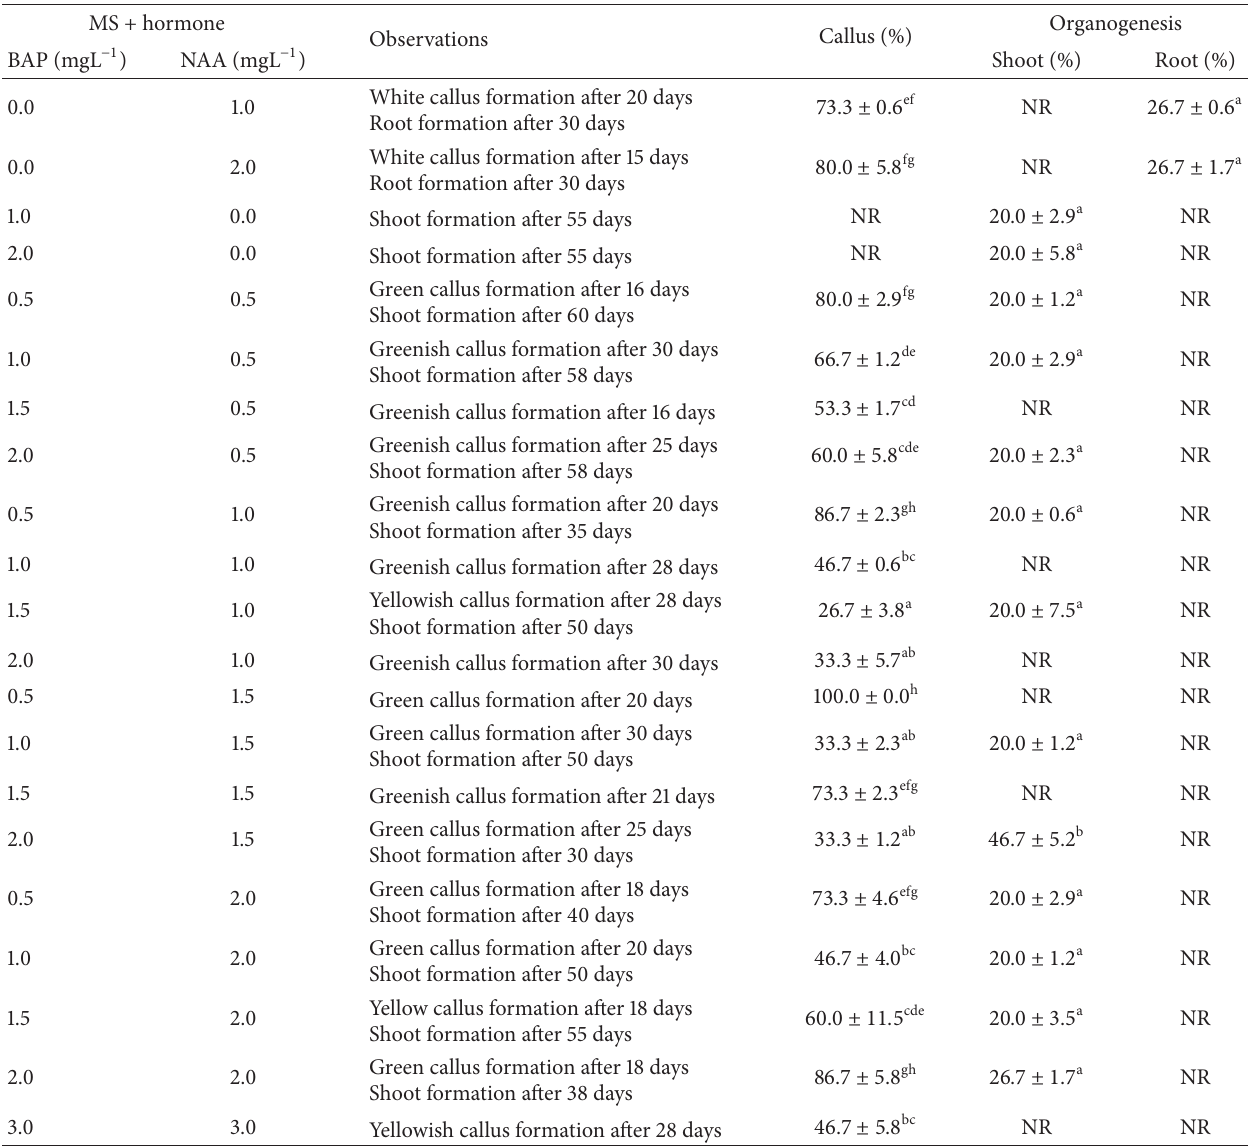
Table 1: The effects of different combinations and concentrations of BAP and NAA on stem explants of Citrus hybrids , cultured on solid MS media at 25 ± 1 ∘ C. Cultures were maintained at 16 hours of light and 8 hours of darkness, with 1000 lux intensity of light. MS + hormone Observations Callus